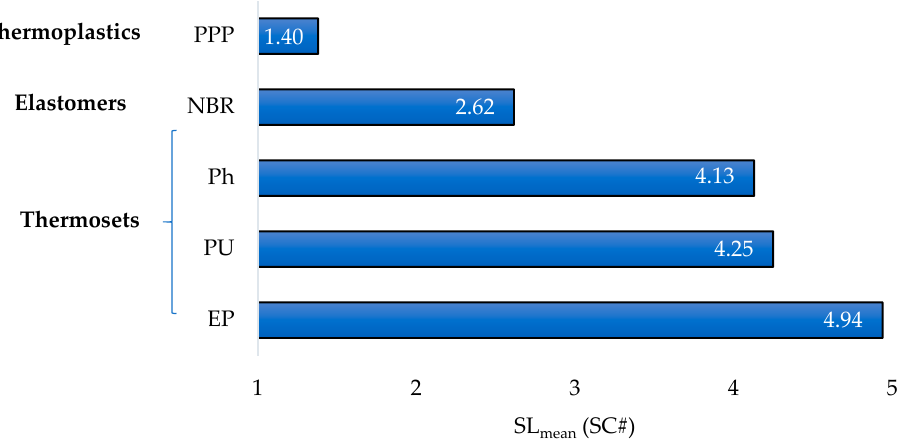
Figure 12. Stringency levels (obtained from selection criteria SC#1 to SC#6).